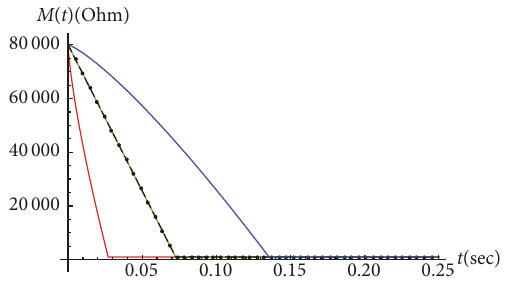
Figure 1: 𝑀(𝑡) of the fractional order memristor excited by a 110 𝜇 A DC waveform: 𝛼 = 0.75 (red), 𝛼 = 1 (green), 𝛼 = 1.25 (blue), and HP memristor (black